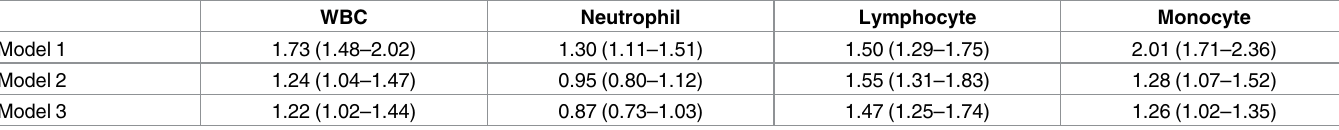
Table 3. Cox proportional hazard regression analyses for cardiovascular disease according to tertiles of total and differential WBC counts.